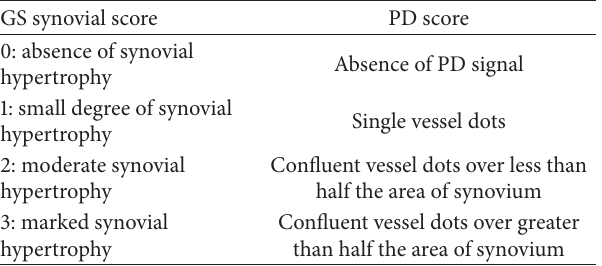
Table1:SubjectiveGSandPDscoringsystemforUSimagesofMCP, PIP, and DIP